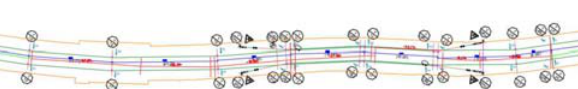
Fig. 7: Detection of area of inconsistency between the LAC of the infrastructure drawings and that of the point cloud